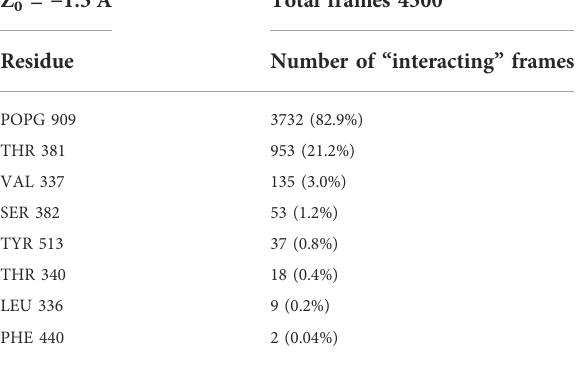
Figure 4. These assignments are indicated for each of the four Systems by the color code of the horizontal double arrows. The different lengths of the double arrows correspond to the time lengths of the interactions (see Supplementary Figures S4 – S7 for a complete annotation of the PMF pro fi les). In all four Systems, the interval along the reaction coordinate where the K + ion interacts with E313 coincides with the local minimum at the EC end in the PMF pro fi le, suggesting that E313 serves as an attraction point for the ion at the EC end of the groove. The PMF maximum (7 kcal/mol peak) for the in-groove POPC construct, System 3, is located in the interval where the K + ion interacts with the POPC lipid (from Z = − 3 Å to Z = 4.75 Å), suggesting that TABLE 1 Illustration of frame-counting results for the 3Å proximity to K + in an umbrella sampling window (the center of the window Z 0 is − 1.5 Å away in Z direction from the C α atom of residue T381) in System 1. Thetotal numberofframes inthe PMFwindows is4500 and aninteractionwiththepotassiumionandisconsidered “ critical ” if it is present in > 2250 frames (i.e., > 50%). Note, however that the total number of interactions is > 4500 because in a single frame, the K + ion can interact with several residues. Thus, the sum of percentage in the second column is not 100%.